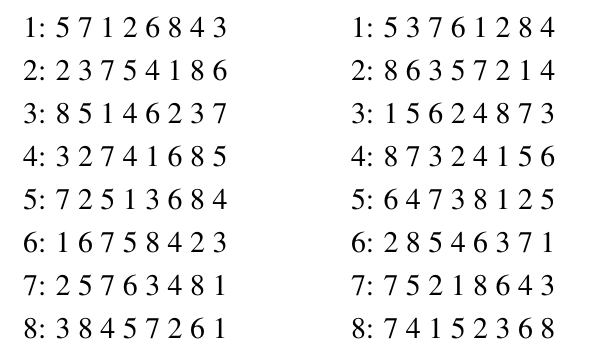
Table 1. An example of a stable marriage (SM) instance of a size of